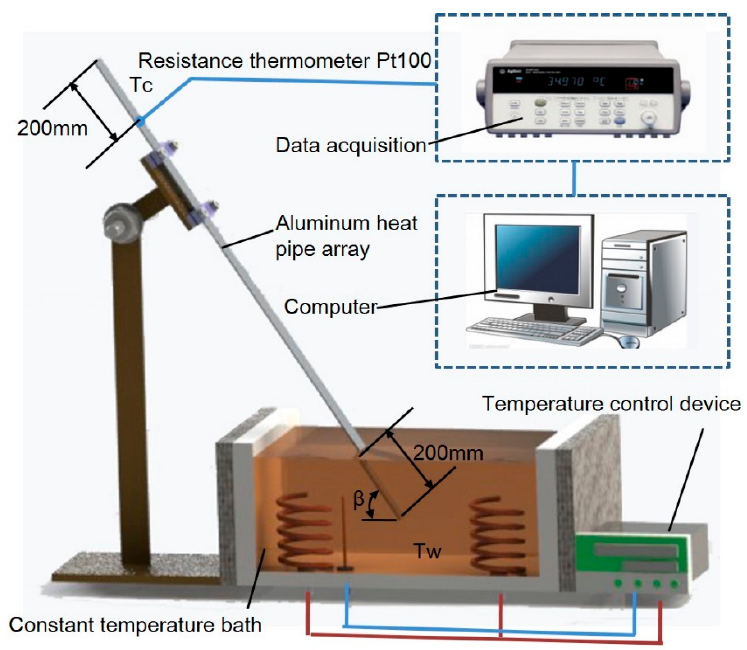
Figure 3. The test setup to characterise heat pipe start-up performance.